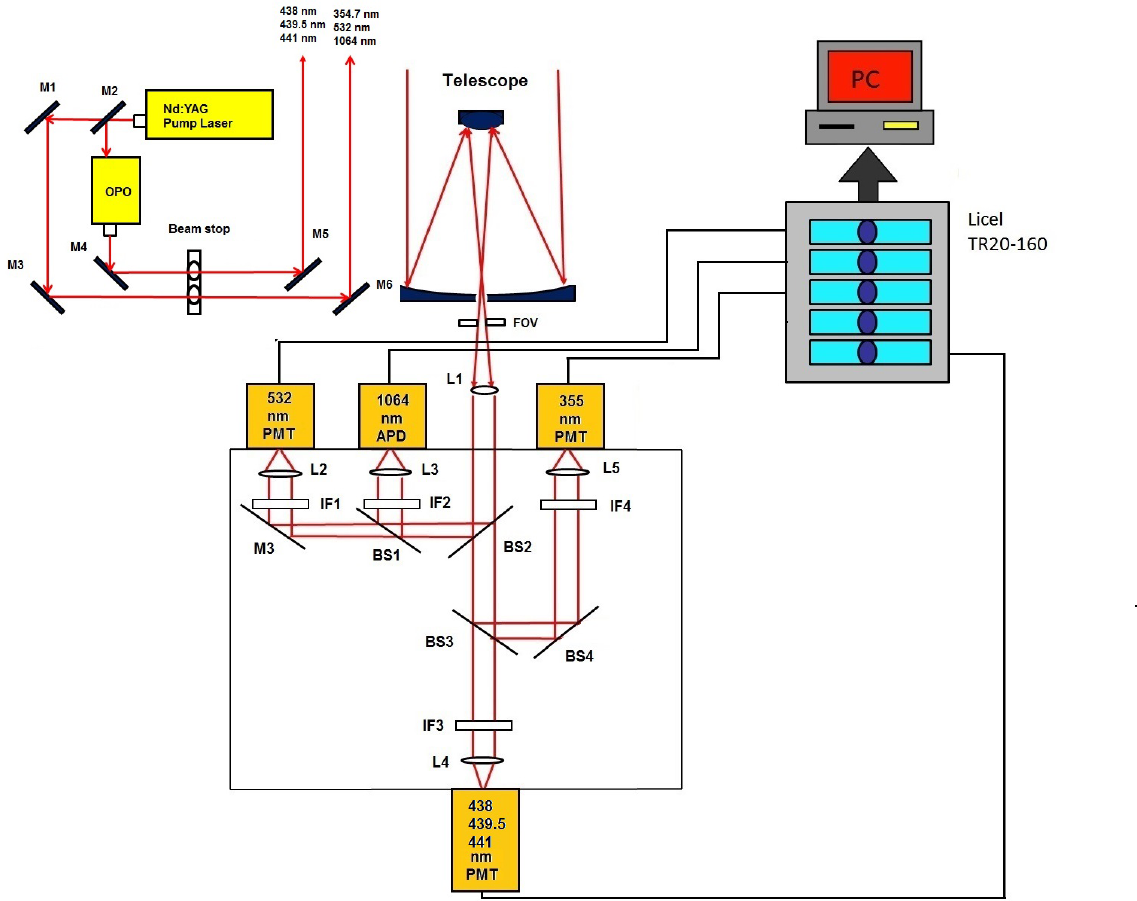
Figure 4. HU lidar system (L: lens; M: mirror; BS: beam splitter; IF: interference filter; FOV: field of view; PMT: photomultiplier tube; APD: avalanche photodetector).